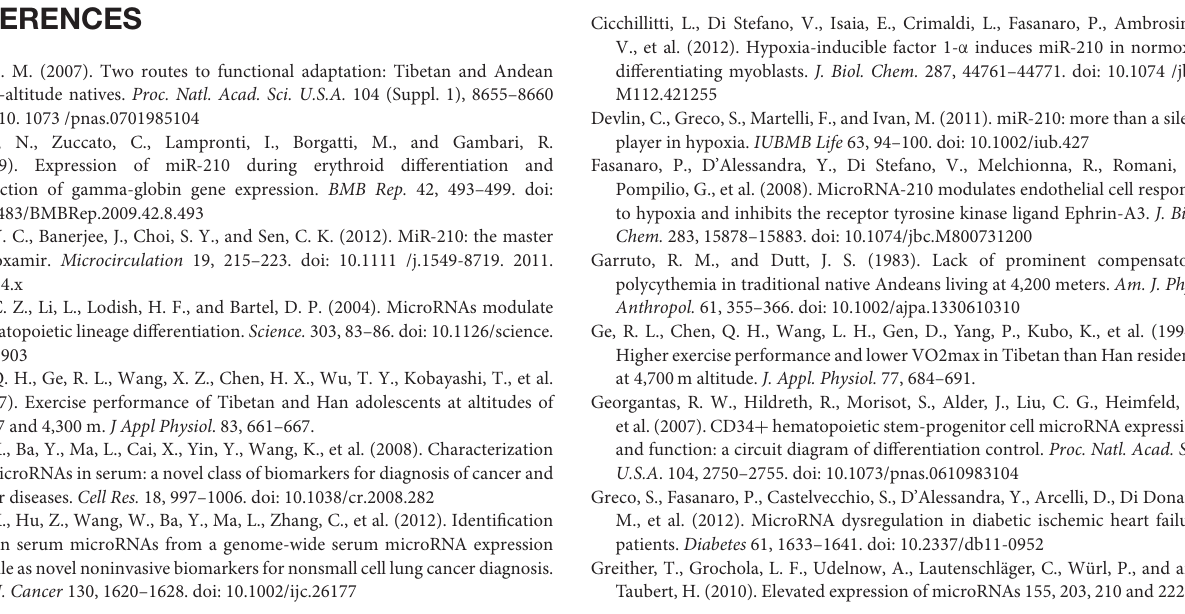
Figure S1 | The Cq value of MIR2911 in plasma samples from the Nanjing Han, Tibet Han, and Tibetan groups. Figure S2 | Standard curve of miR-210-3p using synthetic miRNA. Figure S3 | The Cq values of U6 in peripheral blood cells samples from the Nanjing Han, Tibet Han, and Tibetan groups. Figure S4 | The relative concentrations of miR-210-3p in plasma samples from Nanjing Han, Tibet Han, and Tibetan